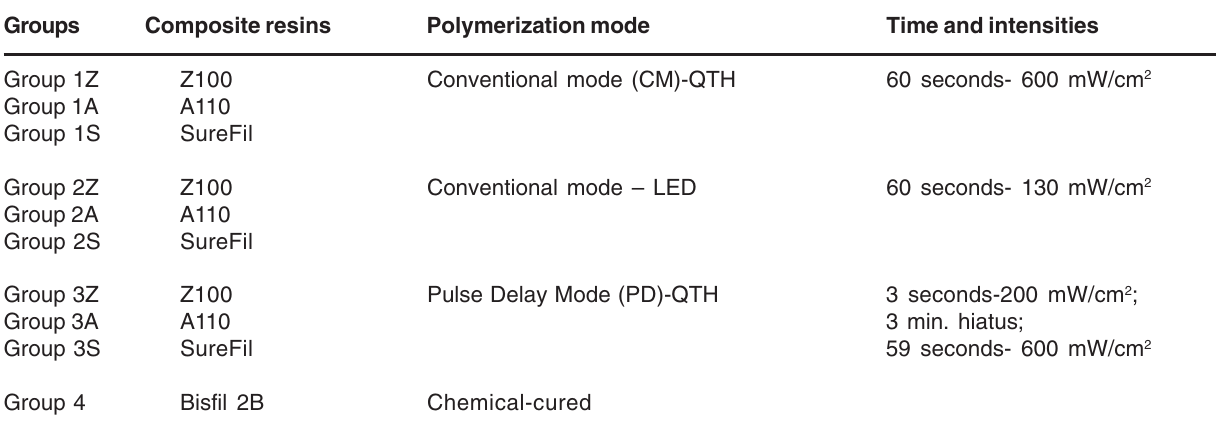
TABLE 2- Description of the experimental groups and polymerization Groups